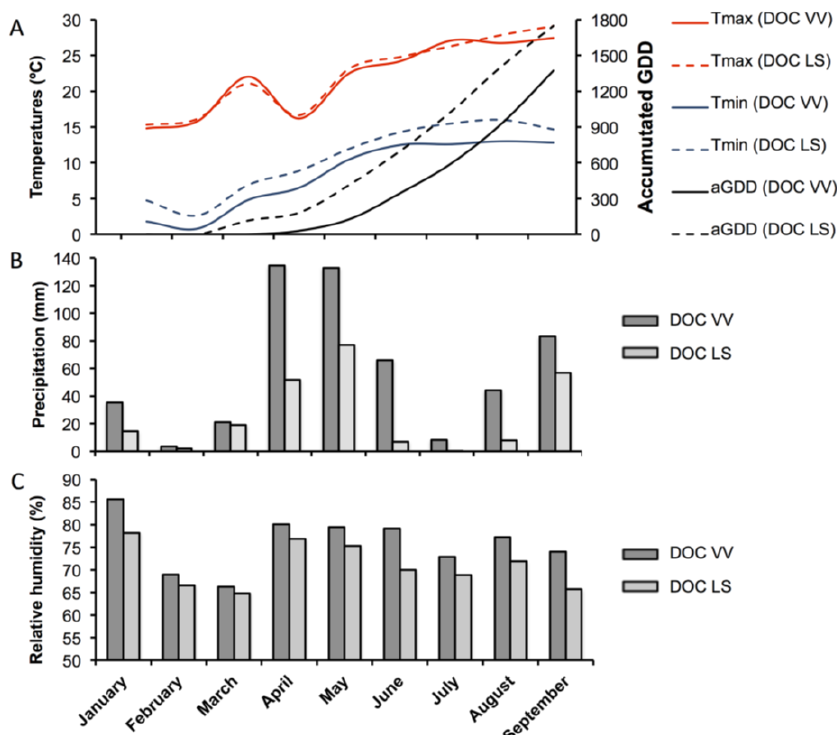
Figure 8. Meteorological and agrometeorological elements from the DOC VV and DOC LS regions from the January until October, 2012, season. Maximum (Tmax) and minimum (Tmin) temperatures and accumulated grown degree days (aGDD) ( A ); precipitation levels ( B ); and relative humidity ( C